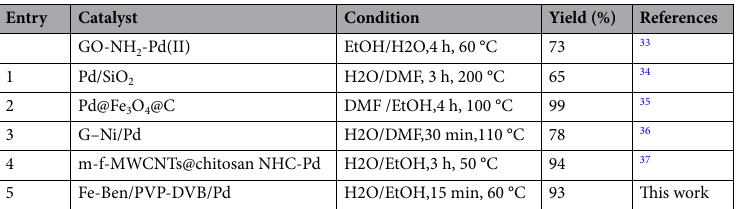
Table 3. Comparison of the performance of Fe-Ben/PVP-DVB/Pd nanocatalyst in the model Suzuki–Miyaura coupling reaction to some Pd catalysts reported in the literature.